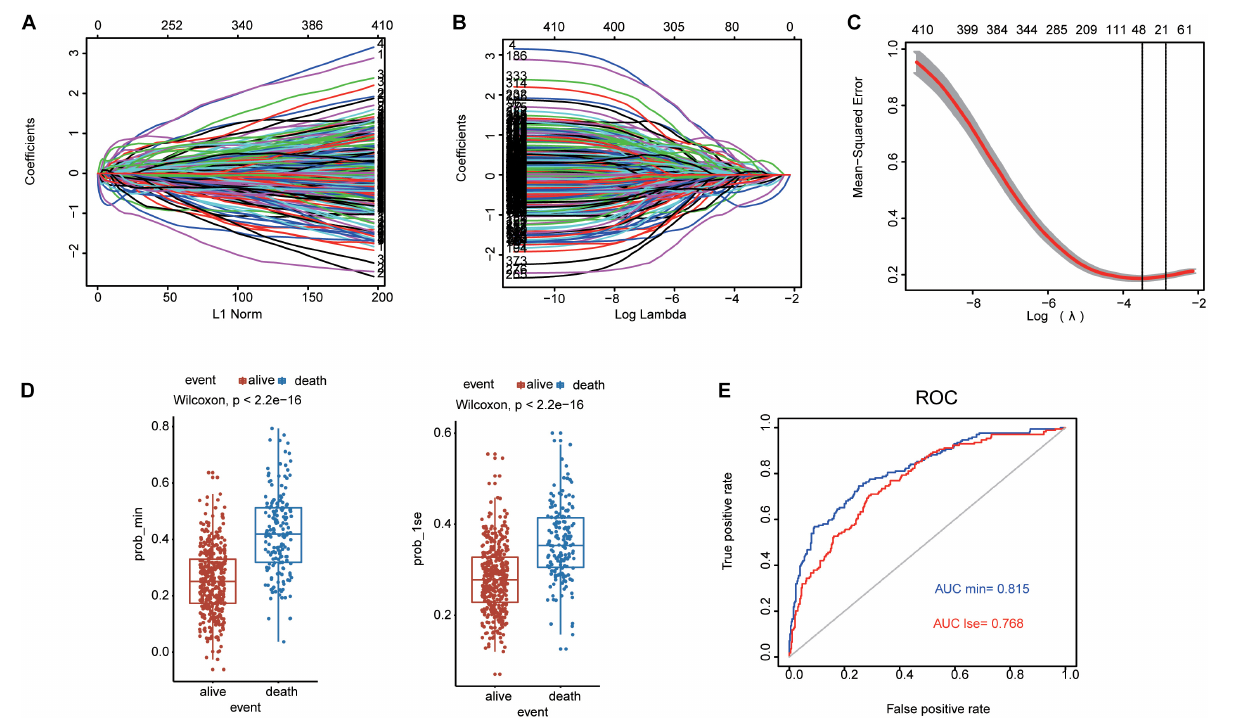
FIGURE 2 | Lasso penalized Cox regression analysis of SE-associated 410 genes. (A,B) The coefficient values at varying levels of penalty. (C) The identification of best Lambda value. The left solid vertical line is the logarithm of lambda.min (35-gene group), the right solid vertical line is the logarithm of lambda.1se (13-gene group). (D) Two models based on lambda.lse and lambda.min are used to distinguish the survival and death events by the Wilcoxon test. (E) ROC curves are used to compare the predictive performance for prob-min and prob-1se to predict patient